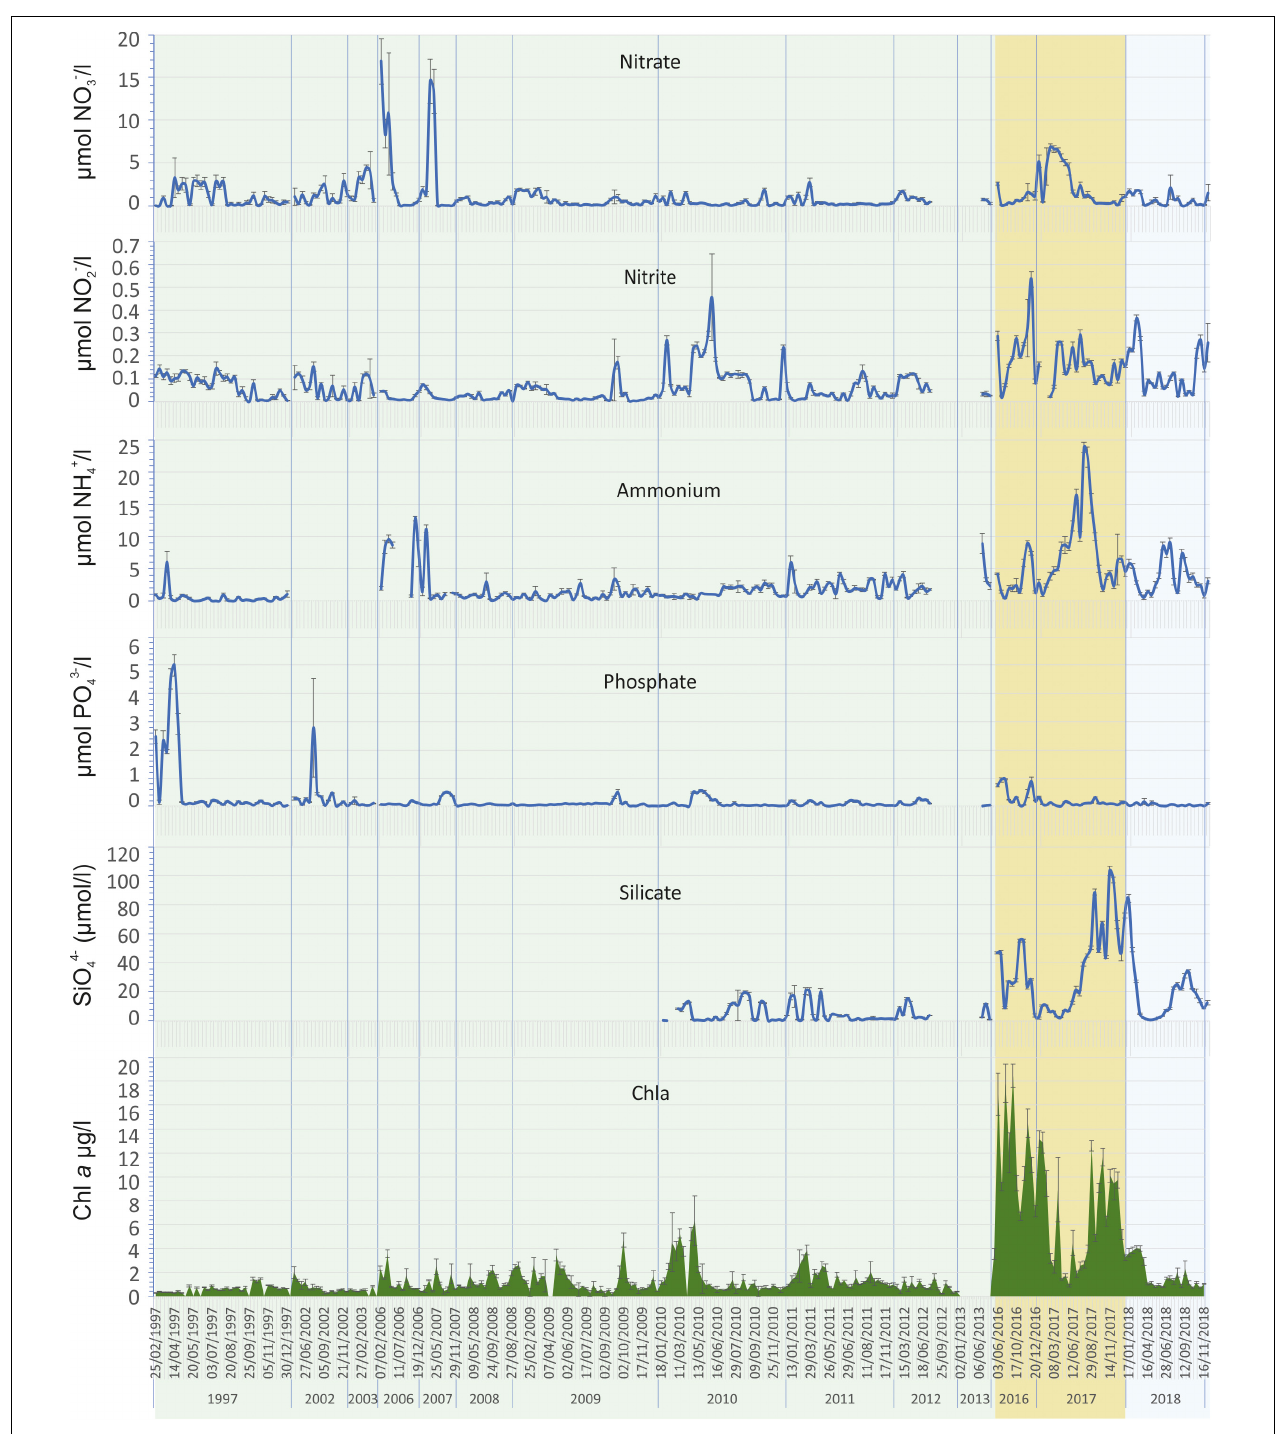
FIGURE 4 | Evolution of the main chemical variables (nitrate, nitrite, ammonium, phosphate, and silicate) and chlorophyll a concentration characterizing the trophic status during the study period in the Mar Menor lagoon water column. Prebreak phase is highlighted in green, Break phase in ochre, and Recovery in light blue.